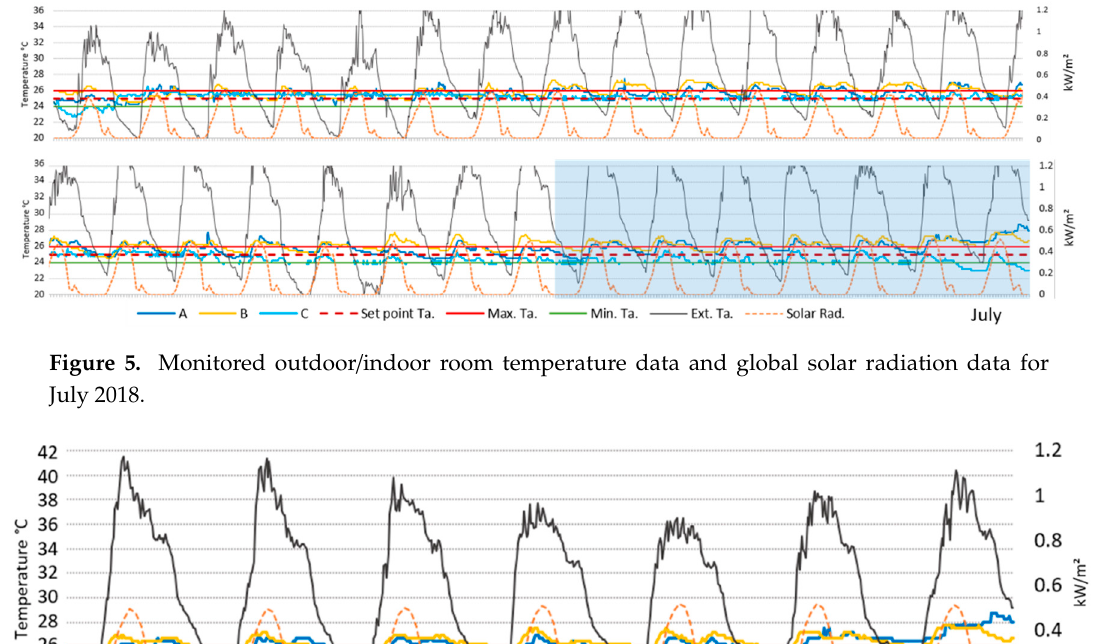
Figure 4. Monitored data collected for rooms during the selected week, June 22nd to 28th.